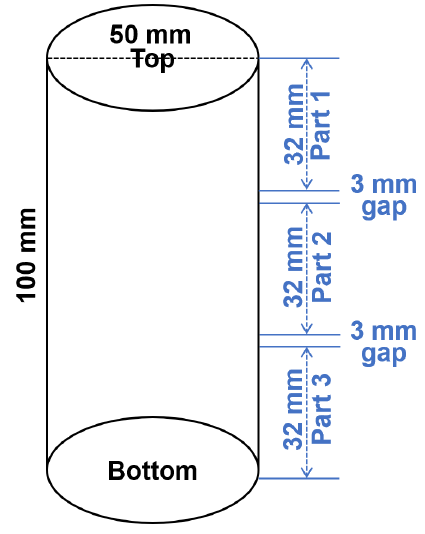
Figure 3. Schematic diagram of the geopolymer cylinder cutting procedure. The 3 mm gaps were reserved for the sample loss during cutting.